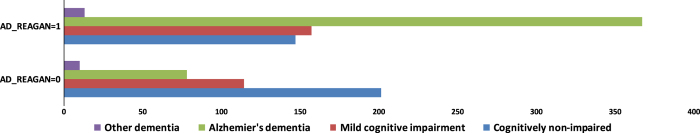
Overlaps between pathologic and clinical diagnosis of Alzheimer’s dementia in ROSMAP.We illustrate the distribution of clinical diagnoses found in the ROSMAP subjects that meet a pathologic diagnosis of AD and in those that do not. We used the NIA-REAGAN guidelines for a pathologic diagnosis of AD, and all subjects were diagnosed as either having AD (AD_REGAN=1) or not (AD_RAEGAN=0). The clinical diagnosis of Alzheimer’s dementia was performed based on a review of all available clinical data by neurologists with expertise in dementia. Participants not fulfilling diagnostic criteria for AD dementia were classified as having mild cognitive impairment, being cognitively non-impaired, and having another form of dementia.